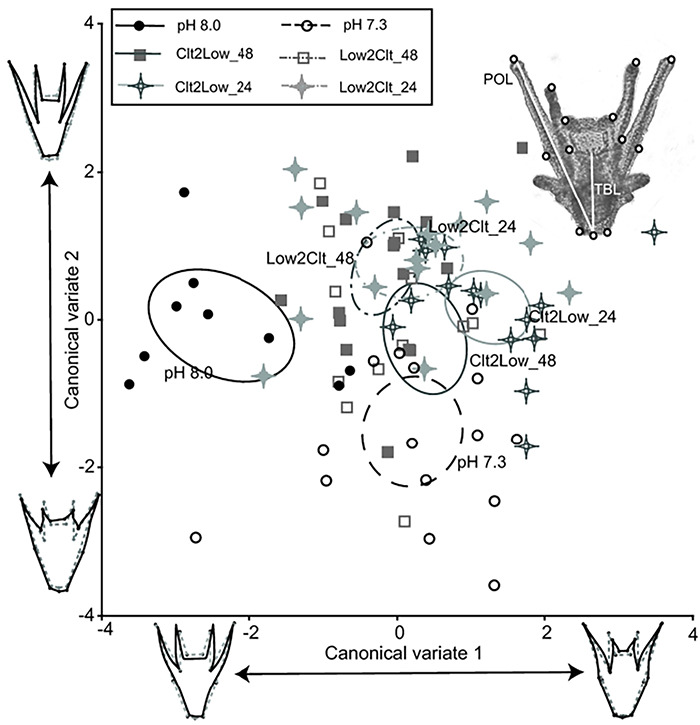
Landmark analysis shows the overall shape of larval sea urchins changed when exposed to acidification stress. Thirteen landmarks were used (circles in the top right inset, total body length (TBL) and postoral arm length (POL) are also labelled). The body shape (V-shape vs. U-shape, CV1) explained 37.6% of the variance, and relative arm length (CV2) explained 27.4% of the variance. Individuals exposed to fluctuations appeared to have an intermediate form. Each data point represents an individual measured (n = 15 for each treatment), and the 90% confidence ellipse of the mean is also plotted. Wrapped wireframe (solid line) illustrates the shape change compared to the mean shape (grey, dotted line).